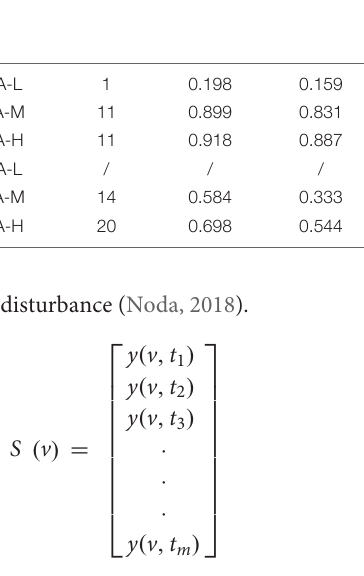
TABLE 1 | Parameters for PLS-DA models in parts and regions discrimination based on three levels of data sets. Data Model RMSEE RMSEP Accuracy (%)